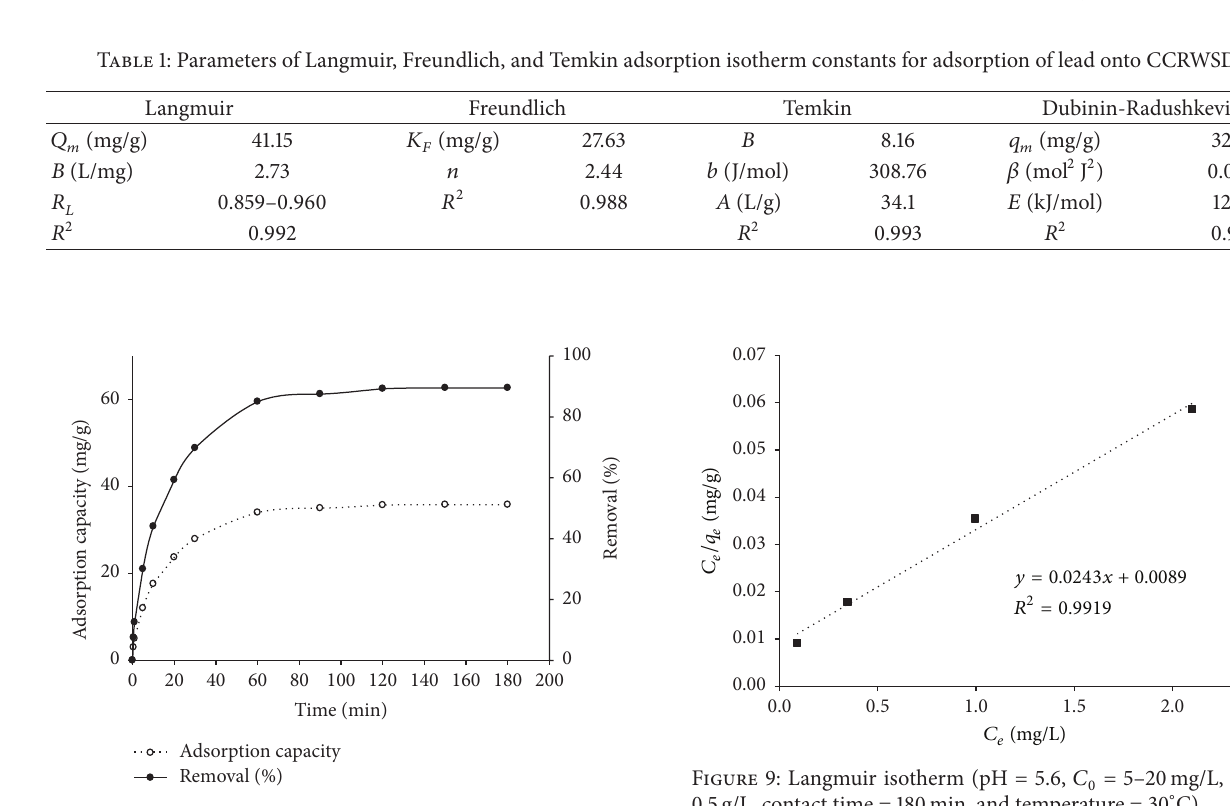
Figure 8: Effect of contact time on the adsorption of lead ions onto CCRWSD ( 𝐶 0 = 20 mg/L, dose = 0.5 g/L, pH = 5.6, and temperature = 30 ∘ C).